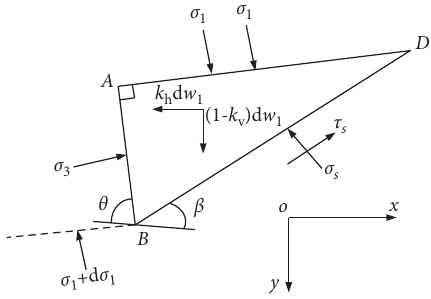
Figure 4: Unit stress diagram at slip surface.